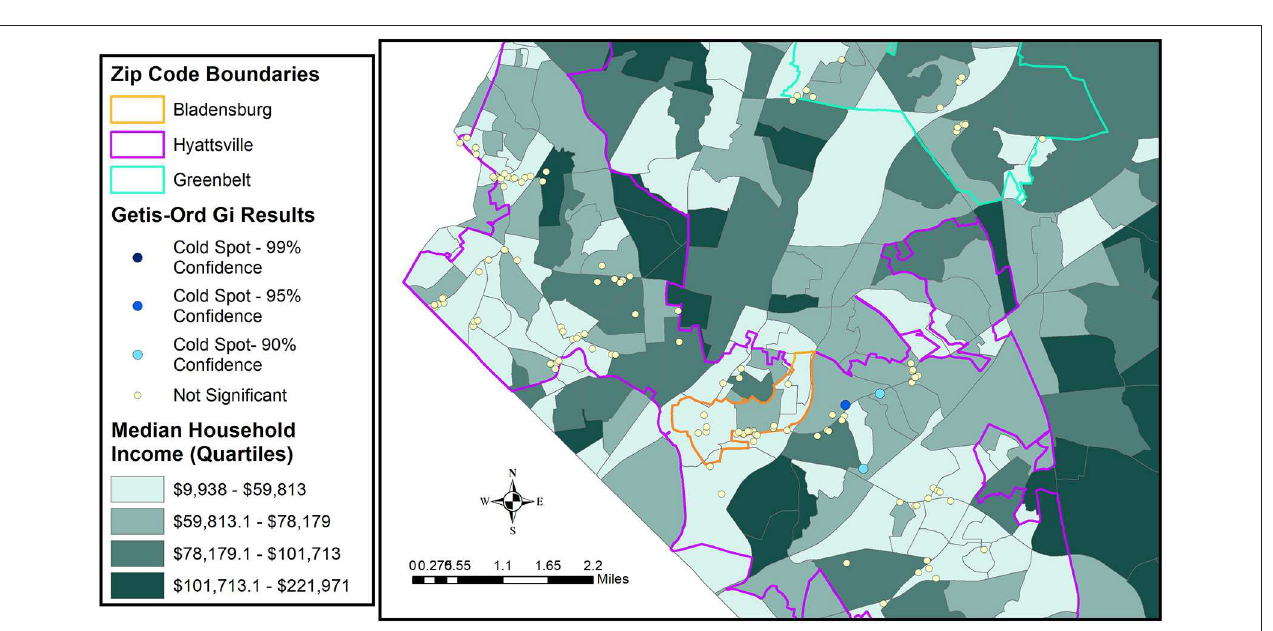
highest percentage of non-White residents within a half-mile of both food stores (92%) and fast food outlets (74%) while Greenbelt had the lowest for both fast food outlets (56%) and food stores (67%) ( Table 4